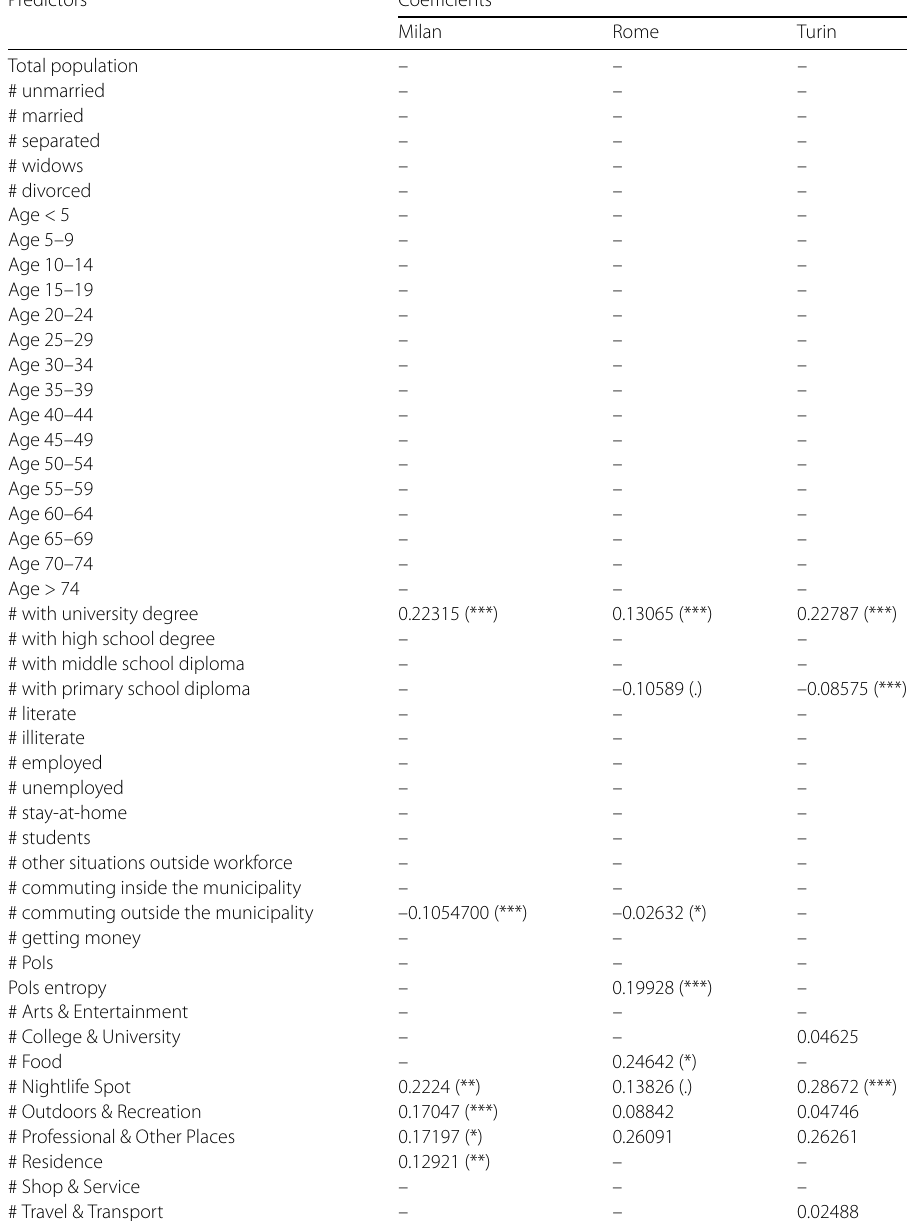
Table 4 Lasso regression for Italian cities. Each cell contains the coefficient estimated by Lasso regression. Statistical significance is reported as (***) = p < 0.001, (**) = p < 0.01, (*) = p < 0.05, (.) = p <